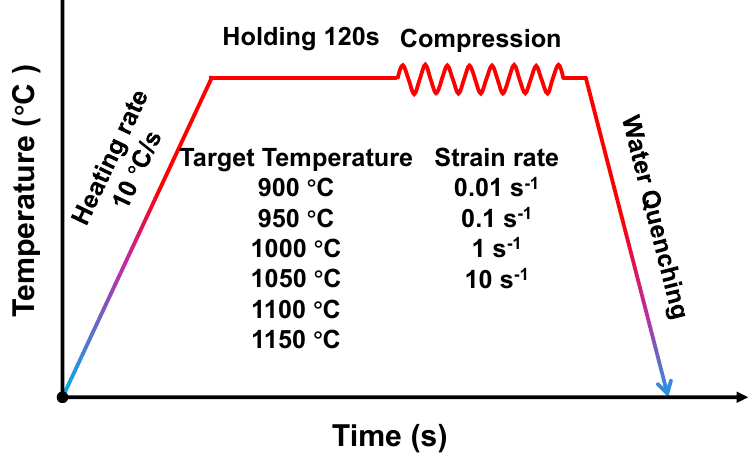
Figure 1. Schematic of thermomechanical history in the hot compression tests.